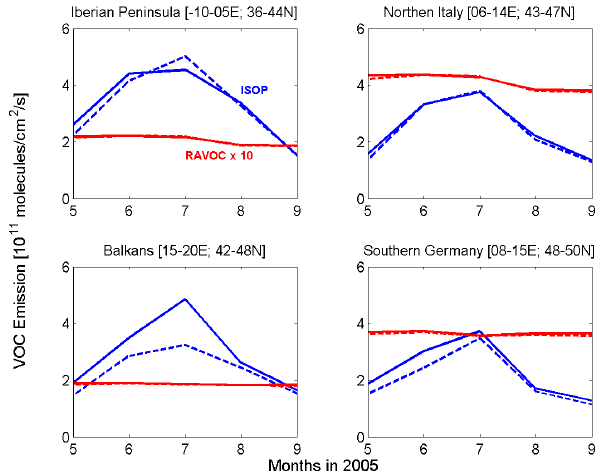
Fig. 6. Monthly emissions (10 11 moleculescm − 2 ) of isoprene (blue), and reactive anthropogenic VOCs (red) averaged over selected regions during May–September 2005. The continuous lines denote a-priori emissions and the dashed lines a-posteriori emissions. Please note that RAVOC emissions are multiplied by 10.